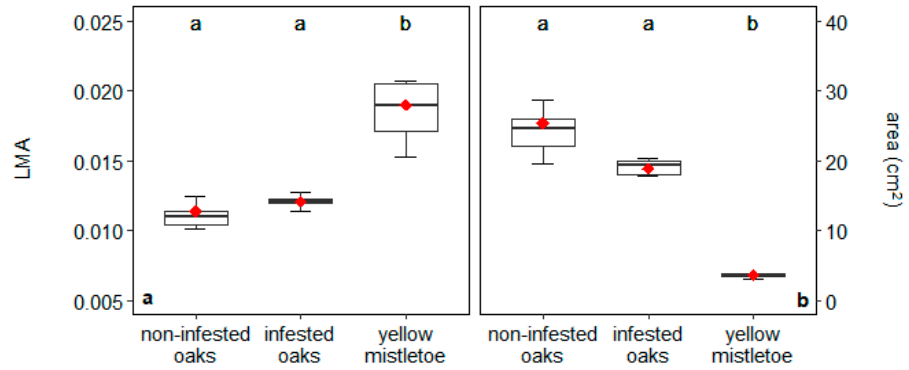
Figure 5. Leaf mass area ( a ) and leaf area ( b ) of non-infested oaks, infested oaks and yellow mistletoes. The median (black line), 25% quantile (box; 37.5–62.5%), 50% quantile (whiskers; 25–75%) and mean (red diamond) are displayed. Lowercase letters represent statistical significance at the level of p = 0.05.